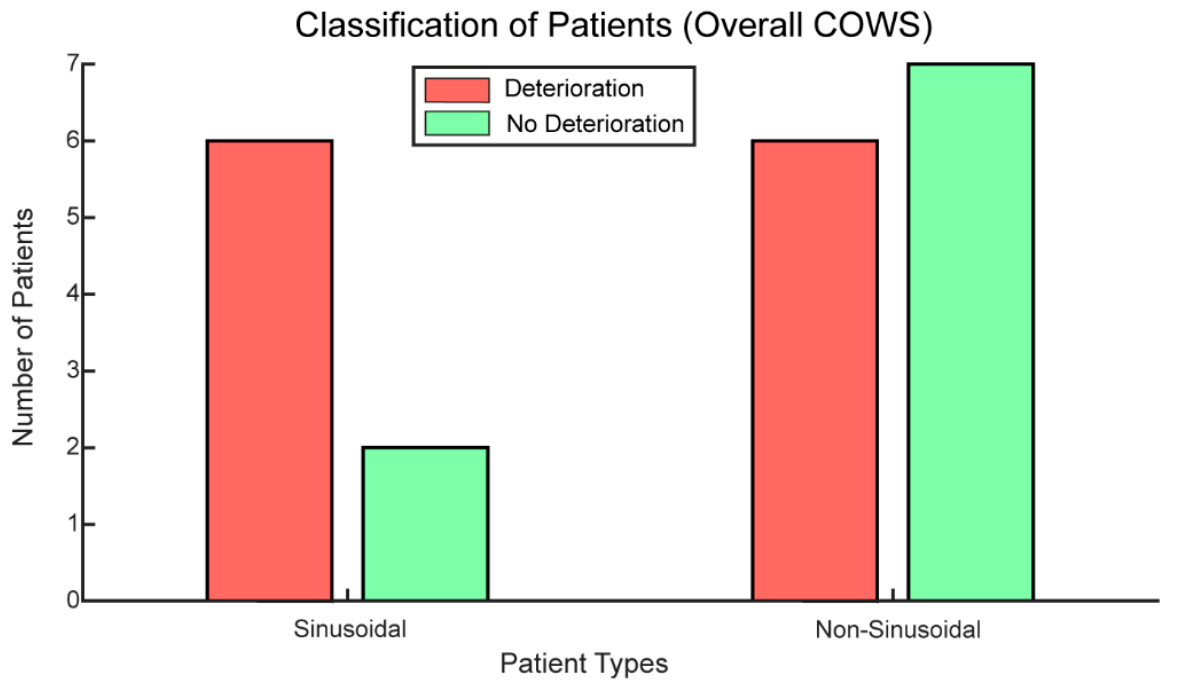
Figure 4. Most patients with OUD classified as “Sinusoidal” had an increase in opioid withdrawal or deterioration over time as measured with the COWS. Patients classified as “Non-Sinusoidal” were as likely to have worsening withdrawal symptoms (deterioration) as no change or an improvement in withdrawal symptoms (no deterioration: no change or a decrease in their overall COWS scores).